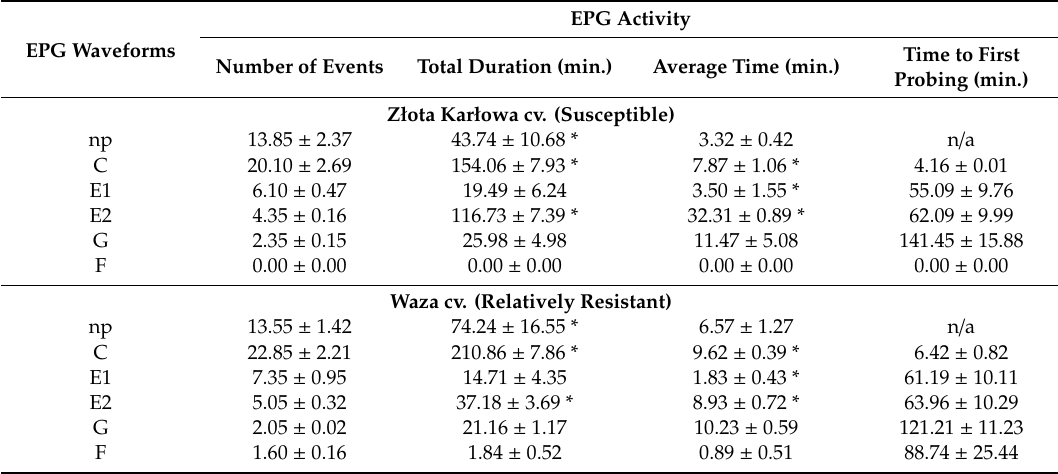
Table 1. Stylet activities of M. dirhodum aphids during feeding on the seedling leaves of the tested maize